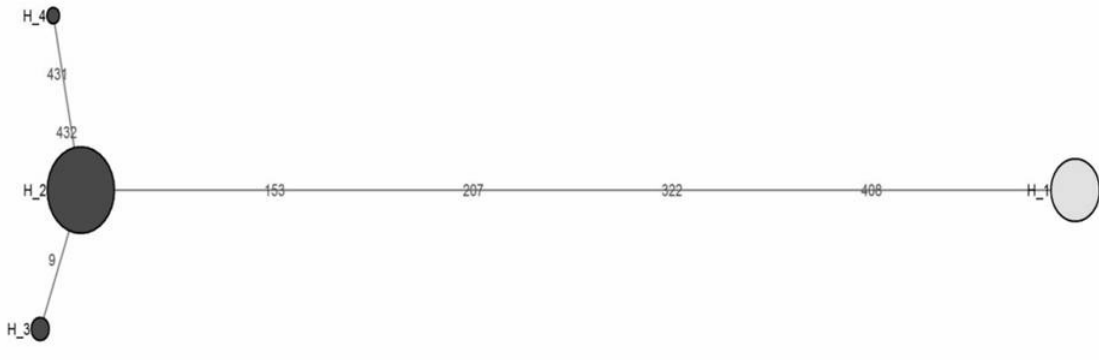
Fig 6 . Haplotype network generated by the comparison of DNA sequences from the cytochrome b region. Population of M. quadrifasciata from semiarid Region (Caatinga) and from the mouth of river São Francisco are represented by dark grey and light grey